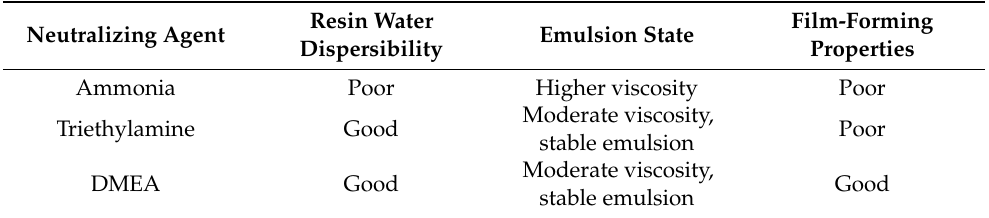
Table 7. Comparison of the performance of different types of